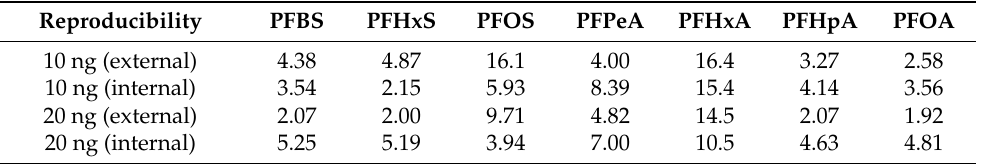
Table 2. Inter-day method precision (reproducibility; fortification amounts: 10 and 20 ng, RSD %, N = 4, k = 2 days) for PFBS, PFHxS, PFOS, PFPeA, PFHxA, PFHpA, and PFOA, presented based on the external and internal standard method.